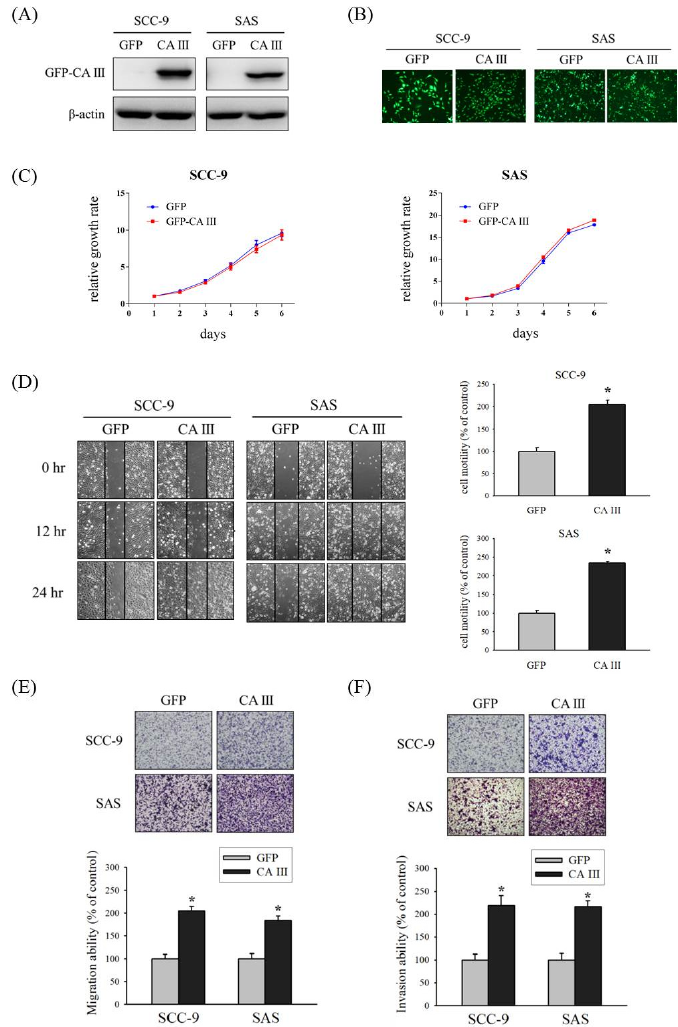
Figure 1. E ff ect of carbonic anhydrase III (CA III) on cell growth, motility, migration, and invasion in oral cancer cells. ( A ) Western blot of SCC-9 and SAS CA III stable clones, where β -actin was used as the internal control. ( B ) GFP and GFP-CA III expression were observed by fluorescence microscopy. ( C ) Growth curves of SCC-9 and SAS were analyzed by the MTT assay after the transfection of GFP or the GFP-CA III vector for 48 h. ( D ) SCC-9 and SAS CA III stable clones were wounded for 0,